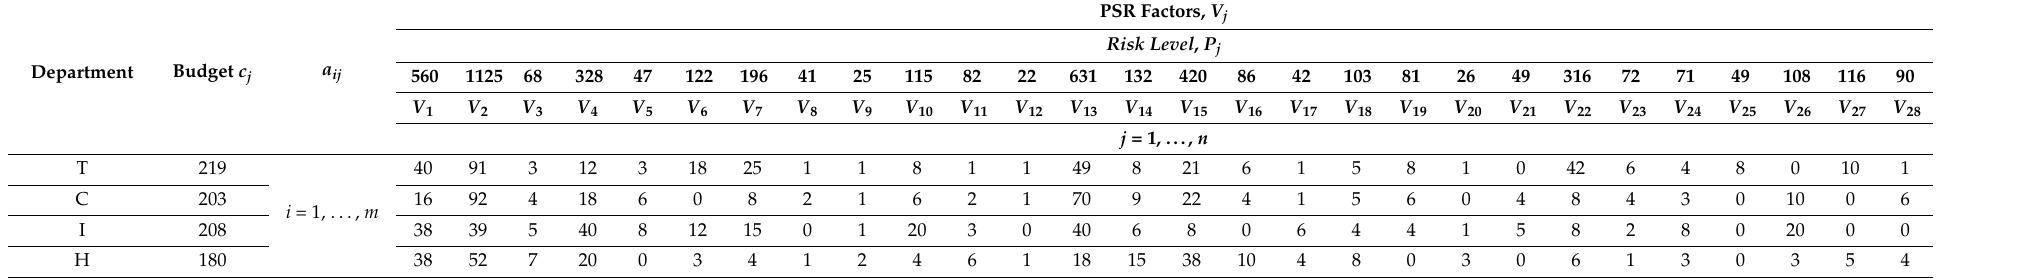
Table 6. HP1 values for the psr optimization problem.